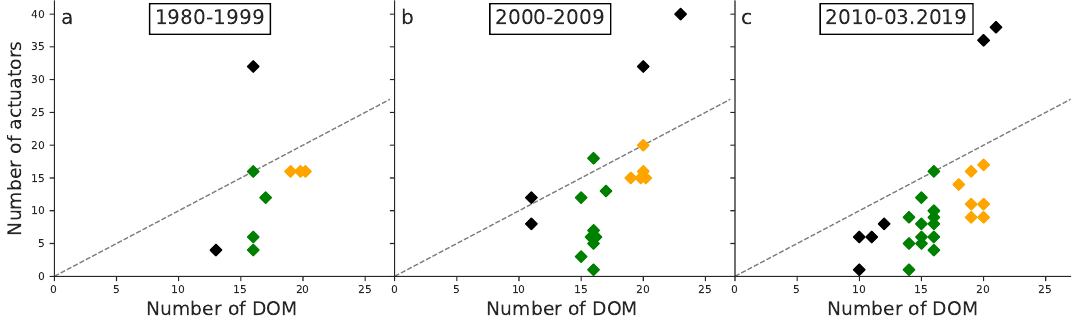
Figure 6. Number of degrees of motion to number of actuator ratio with two main groups of artificial hands highlighted: common, green; more advanced, orange. Statistics presented for three periods of time: ( a ) 1980–1999, ( b ) 2000–2009, ( c )